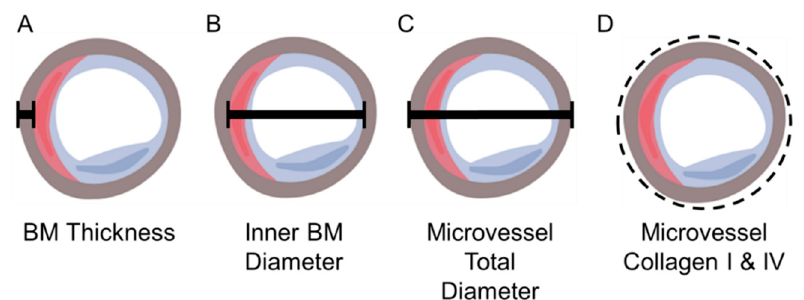
Figure 1. Schematic Representation of Micro-vessel Architecture. The drawing depicts a micro-vessel with endothelial cell (blue), pericyte (red) and basement membrane (BM) (brown). The black bars identify micro-vessel measurements: ( A ) BM thickness, ( B ) BM inner diameter and ( C ) micro-vessel overall diameter. The dashed line ( D ) identifies Area of Interest (AOI) placed around each micro-vessel.